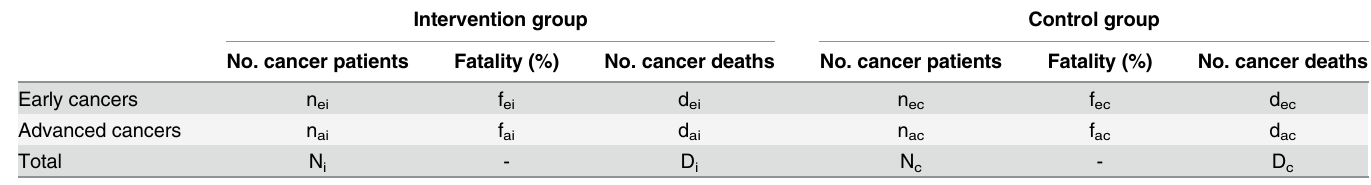
Table 1. Typical results of randomised trials testing the efficacy of interventions aiming at reducing the risk of cancer